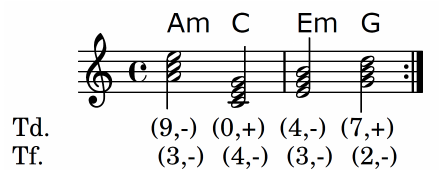
Figure 3. Two bar progression.